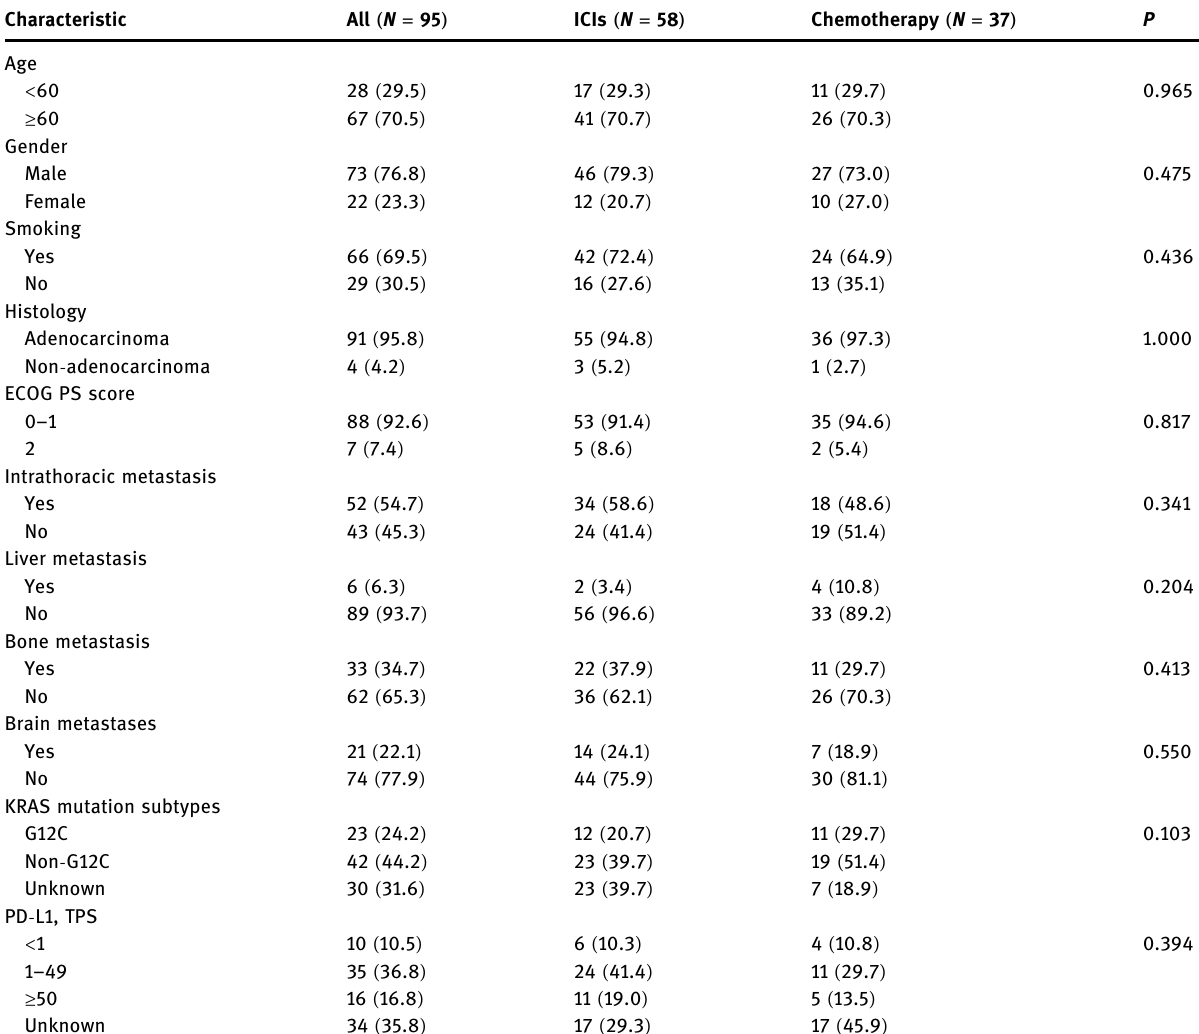
Table 1: Baseline KRAS - mutant patient characteristics